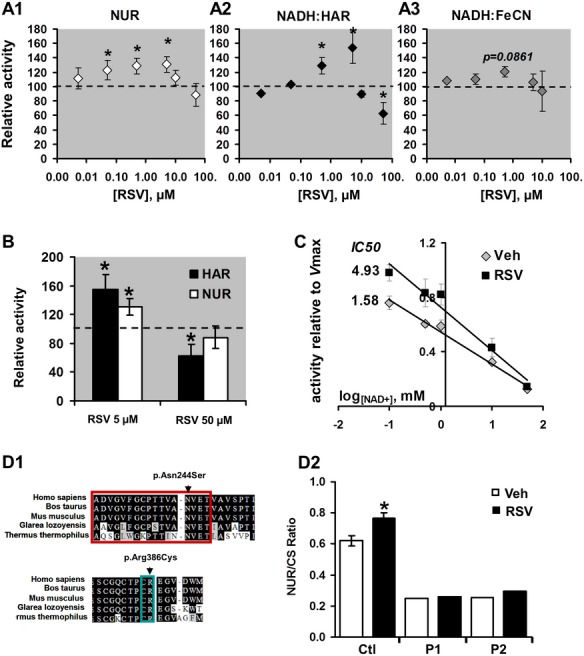
RSV binding to complex I modulates the kinetic of NADH oxidation.
(A) Effect of RSV on the NUR, HAR and FeCN enzymatic reactions catalyzed by complex I on isolated mitochondria. A1: The rates of NADH:Ubiquinone oxido-reduction (the NUR reaction, A1), NADH:HAR oxido-reduction (the NADH:HAR reaction, A2) and NADH:FeCN oxido-reduction (the NADH:FeCN, A3) were measured on isolated CI in the presence of increasing RSV concentrations (5 nM to 50 μM). Reactions were started by the addition of NADH. Data are presented as a percentage of vehicle (DMSO), as mean ± sem of six independent experiments. The (*) indicates significant differences (p<0.05) compared with vehicle. (B) Comparison of the effect of two RSV concentrations (5 and 50 μM RSV) on HAR and NUR reactions on isolated mitochondria. Data are presented as a percentage of vehicle (DMSO) and as a mean ± sem of six independent experiments. The (*) indicates significant differences (p<0.05) compared with vehicle. (C) Effect of RSV on the FeCN reaction and competition with NAD+. The rate of the FeCN reaction was measured in the presence of either DMSO (vehicle) or 5 μM RSV and increasing NAD+ concentrations (0.1–50 mM). IC50 values for the inhibition of FeCN reaction by NAD+ were calculated from the curves normalized to maximal oxidation rates. Data are represented as mean ± sem of six independent experiments. The (*) indicates significant differences (p<0.05) compared with vehicle. (D) Effect of RSV on complex I cells carrying NDUFV1 mutations in the nucleotide binding site. D1: Position of the two exonic mutations on the NDUFV1 amino acid sequence. The NADH binding site is squared in red, and the Fe/S (N3cluster) interacting amino acids are squared in blue. D2: The NDUFV1 mutant fibroblast cells and five controls were incubated with 5 μM RSV, during 24h. The NUR activity was then measured on cell extracts. Data are expressed as the percentage of CI activity in vehicle treated cells and are represented as mean ± sem of n = 5 control cells or as a mean of the triplicate analyses in mutant cells. The (*) indicates significant differences (p<0.05) between vehicle and RSV treated cells.